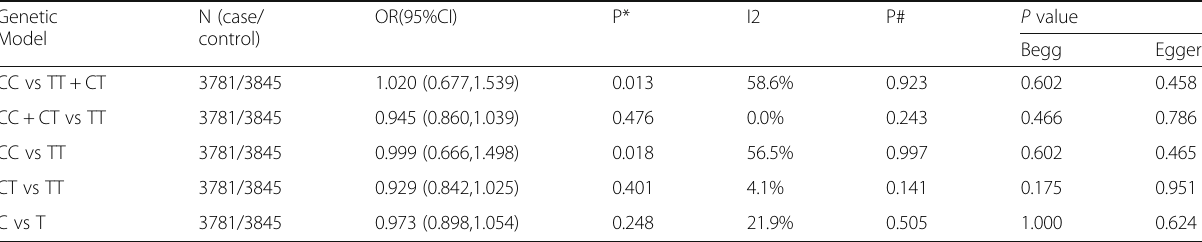
Table 6 Meta-analysis of TNF- α 1031 T/C polymorphisms and CAD susceptibility Genetic